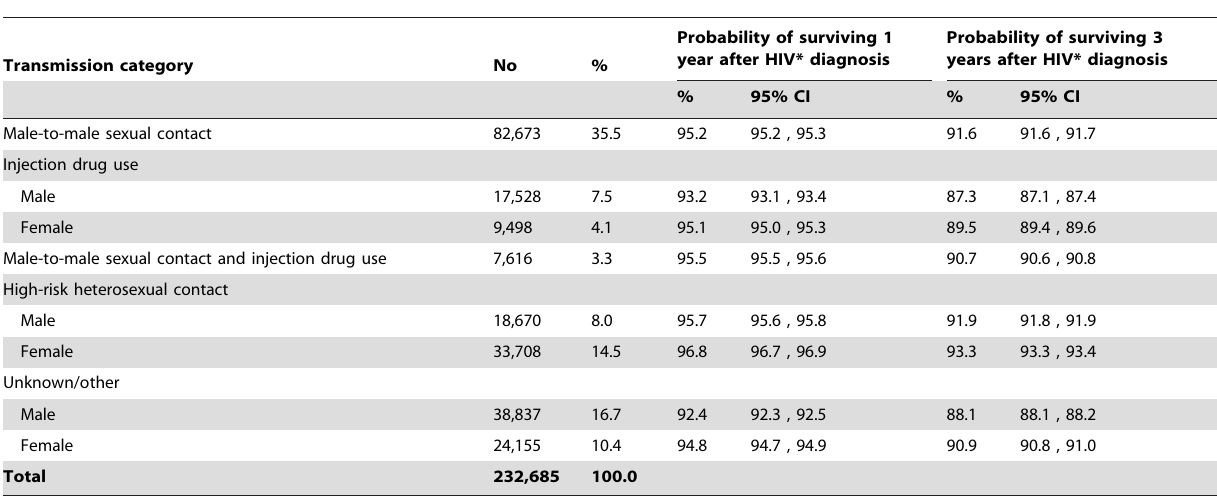
Table 2. Survival of persons with HIV* diagnosis by transmission category in 1996–2004, 33 U.S. States.